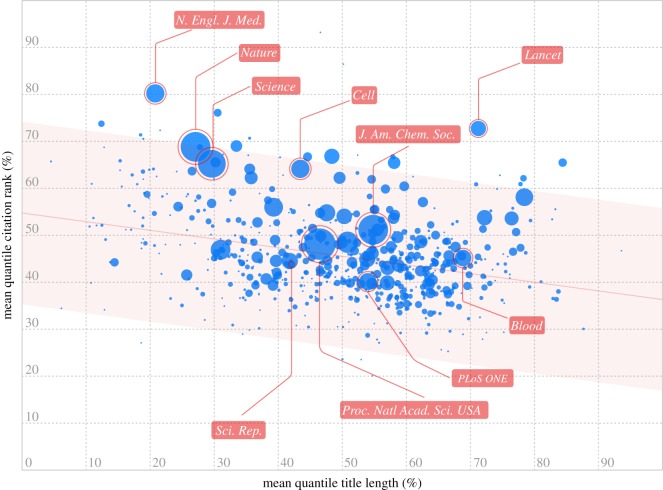
Journals which publish papers with shorter titles receive more citations per paper. For each year in our dataset, we rank all of the papers in terms of the number of citations received and in terms of the length of the titles, and transform these ranks into percentiles for a given year. For each journal, we then calculate the average quantile of the citations and of the title lengths, across papers and across years. Here, each blue circle represents a journal, the size of each circle represents the number of papers in our sample for that journal. Again, we find that journals that publish papers with shorter titles also tend to receive more citations per paper (Kendall's τ=−0.19, N=625, p<0.001).